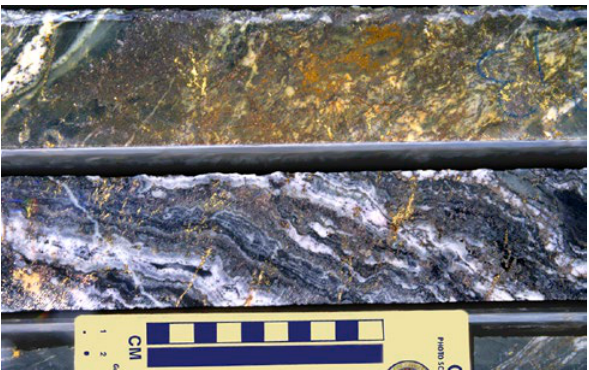
Figure 46. Colloform banding in quartz veins sometimes occupies the whole vein space as in this example from the Abra prospect at Jillawarra, west of Mt Morgan in WA. Some post depositional oozy movement can be seen between the bands and towards the left a small dark stylolite-like vein has a pearl-grey branch veinlet outli- ned by pale silicified margins as it passes up through the colloform